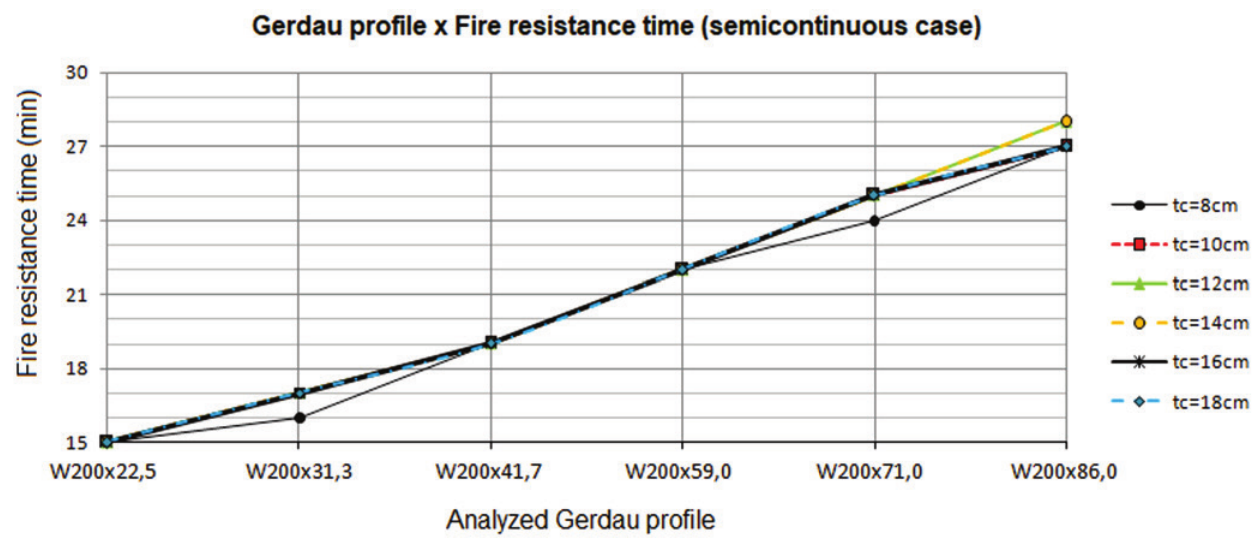
Figure 5 Semi-continuous case fire resistance time (for 0.7 load factor) as function of the analyzed profile (Gerdau W200